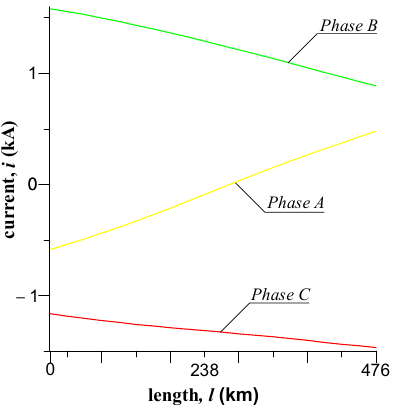
Figure 7. The phase current across the line as a function of distance at t = 0.01 s. The phase current across the line as a function of distance at t = 0.01 s from the time of the voltage turn-on is depicted in Figure 7. As in the case of the voltage, the phase current vs. distance at t = 0.01 s is close to linear since, by then, electromagnetic waves were running repeatedly along the line to its end and back many times at identical parameters. Figure 8 shows phase current waveforms when the line is on and then switches at t = 0.08 s to a state of single-phase short-circuit fault at point A at the end of the line.